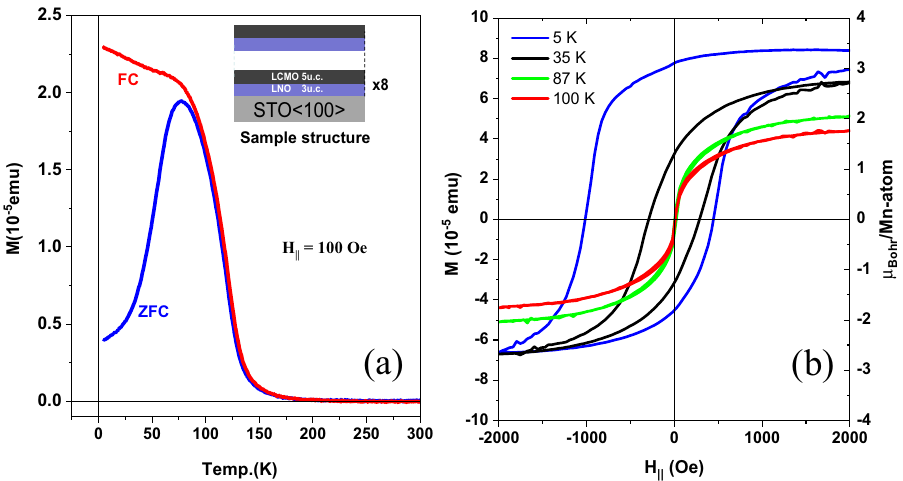
Figure 3. ( a ) Magnetization versus temperature for the [3 u.c. LNO–5 u.c. LCMO]8 superlattices, with the in-set illustrating the sample structure. ( b ) Magnetization versus magnetic field (left-axis) and relative Bohr- magneton (µB/Mn-atom) (right-axis) for the same sample at 5 K, 35 K, 87 K, and 100